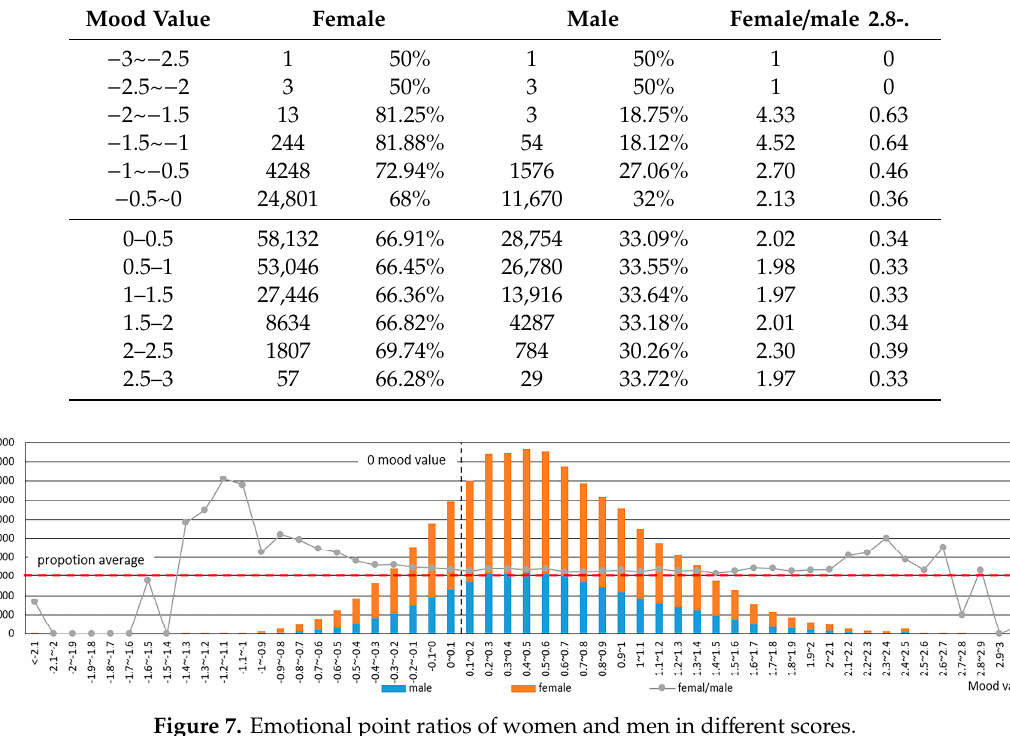
Table 3. Proportion of the distribution of sentiment points in different scores.